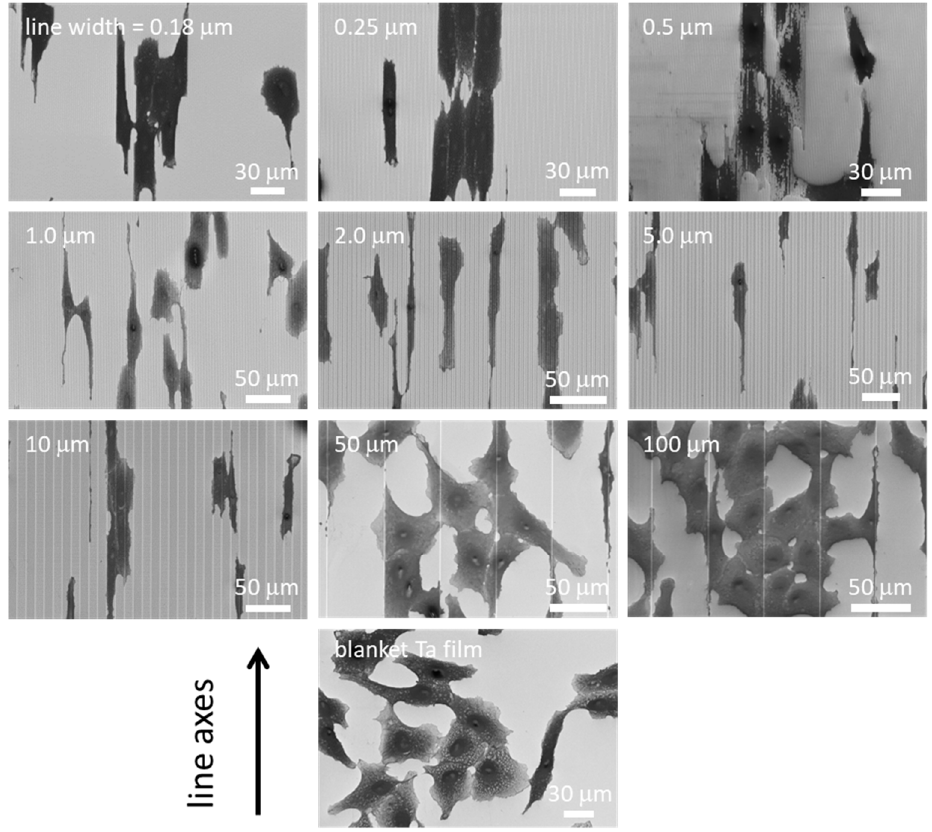
Figure 3. Representative top-down scanning electron microscopy (SEM) micrographs of adherent cells on different comb structures and blanket tantalum (Ta) film. Results show that adherent cells are aligned to the line axes on structures with line widths in the range of 0.18 to 10 µ m. In contrast, cells on the 50 µ m and 100 µ m structures do not align well with the line axes—they are similar to cells randomly distributed on blanket Ta films. All cells were incubated on these specimens for 24 h.